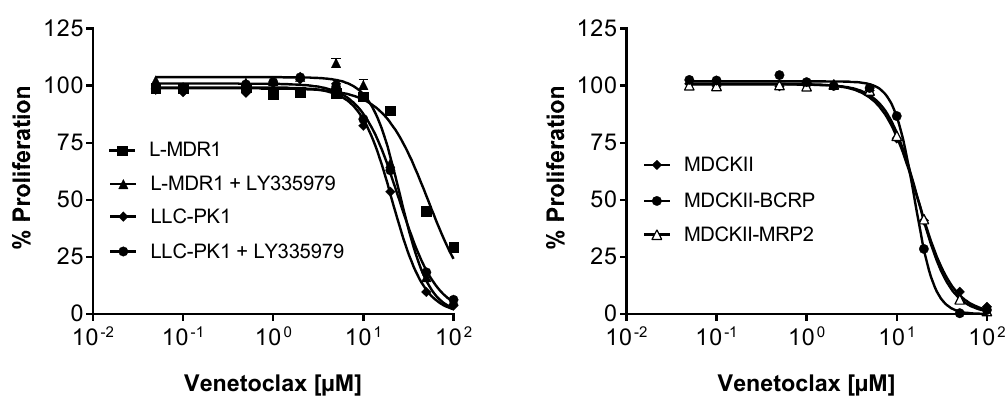
Figure 4. Growth inhibition assay. Concentration-dependent effect of venetoclax (0.05–100 µM) on the proliferation of the P-gp over-expressing cell line L-MDR1, the corresponding parental cell line LLC-PK1 with and without the specific P-gp inhibitor LY335979 (left) and of the BCRP or MPR2 over-expressing cell lines (MDCKII-BCRP, MDCKII-MRP2) and the corresponding parental cell line MDCKII (right). Each curve depicts the results of four experiments with each concentration tested in octuplet. Data are expressed as mean ± SEM for n = 32 wells.